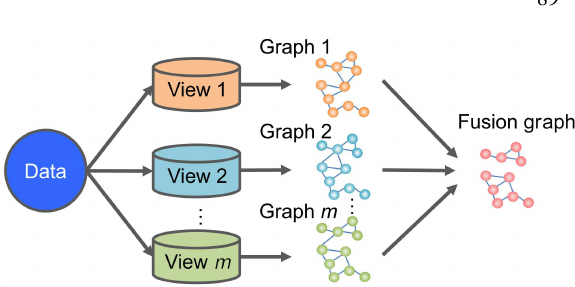
Fig. 6 General procedure of graph-based